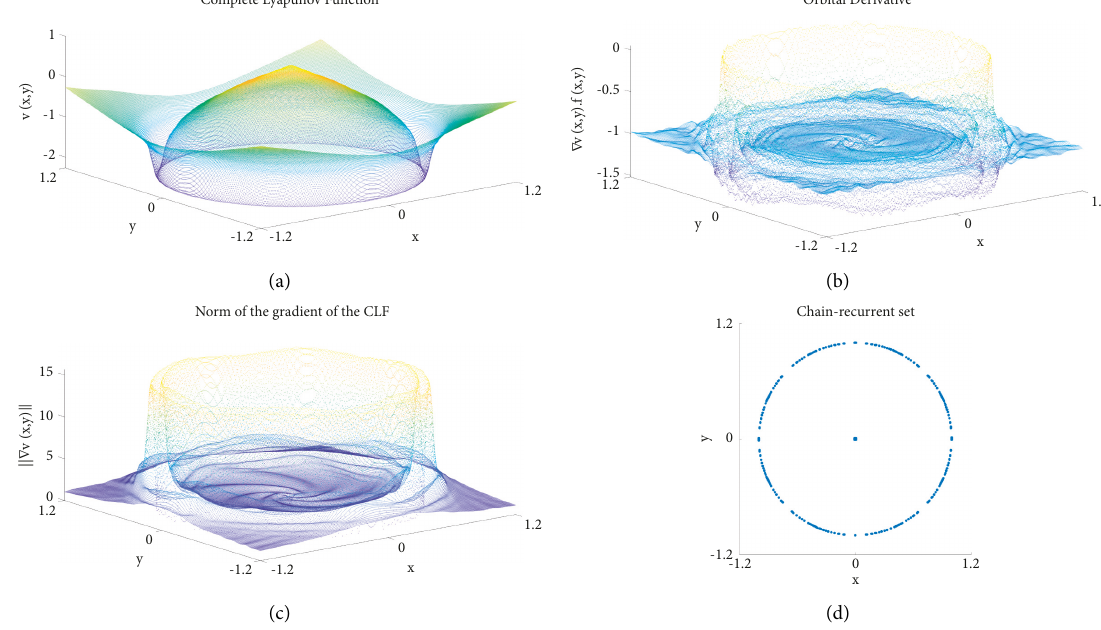
Figure 1: System (18). (a) Complete Lyapunov function v . (b) Its orbital derivative v ′ . (c) Norm of its gradient ‖ ∇ v ‖ . (d) Underestimation of the chain recurrent set C v, 0 . 8